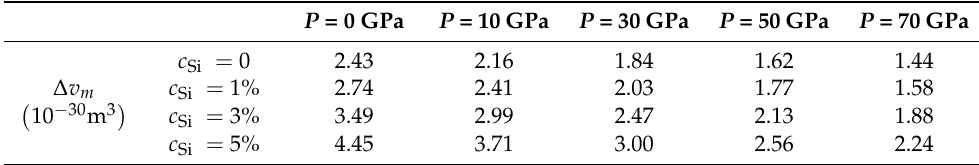
Table 8. Si concentration and pressure dependence of volume jumping ∆ v m T = 300 K.